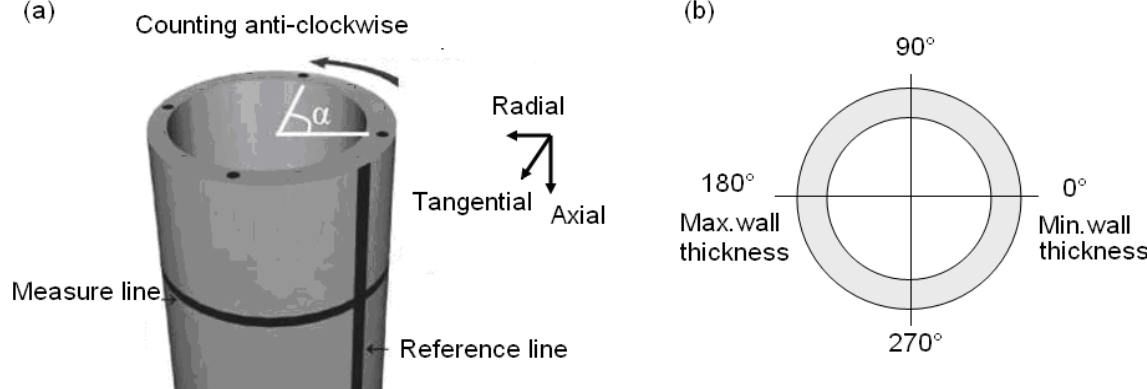
Figure 6. ( a ) Points of measurement and ( b ) measuring points over